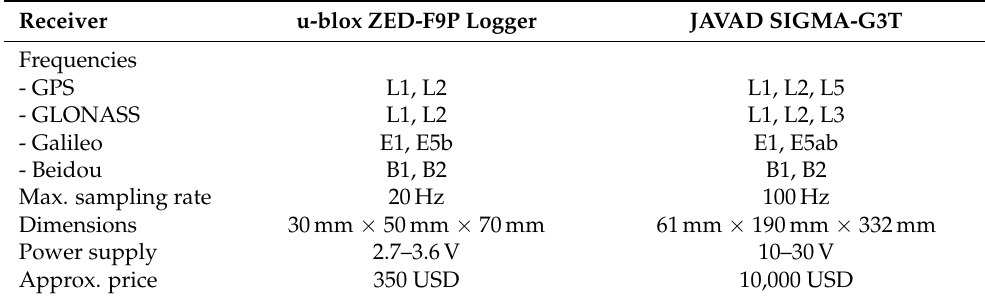
Table 1. Specifications of the GNSS receivers used for the experiments (the price for the ZED-F9P relates to the material costs of the data